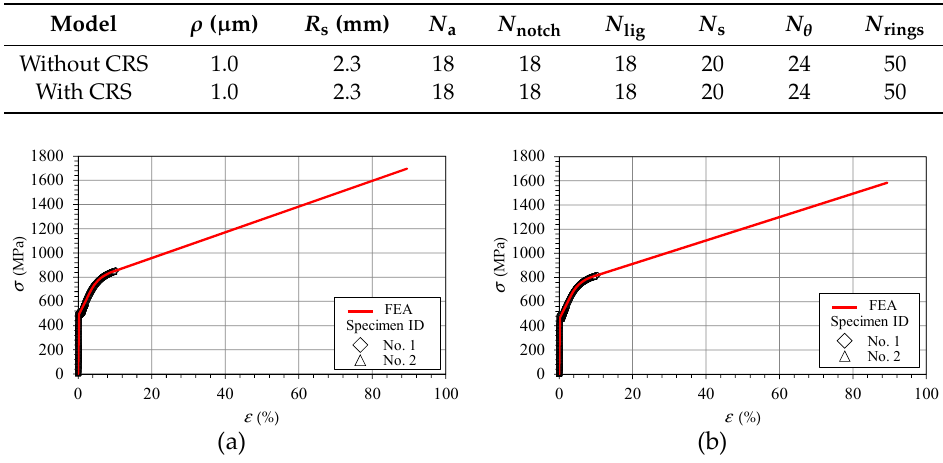
Table 6. Mesh division parameters of the FE model for S45C SE(B) specimens.